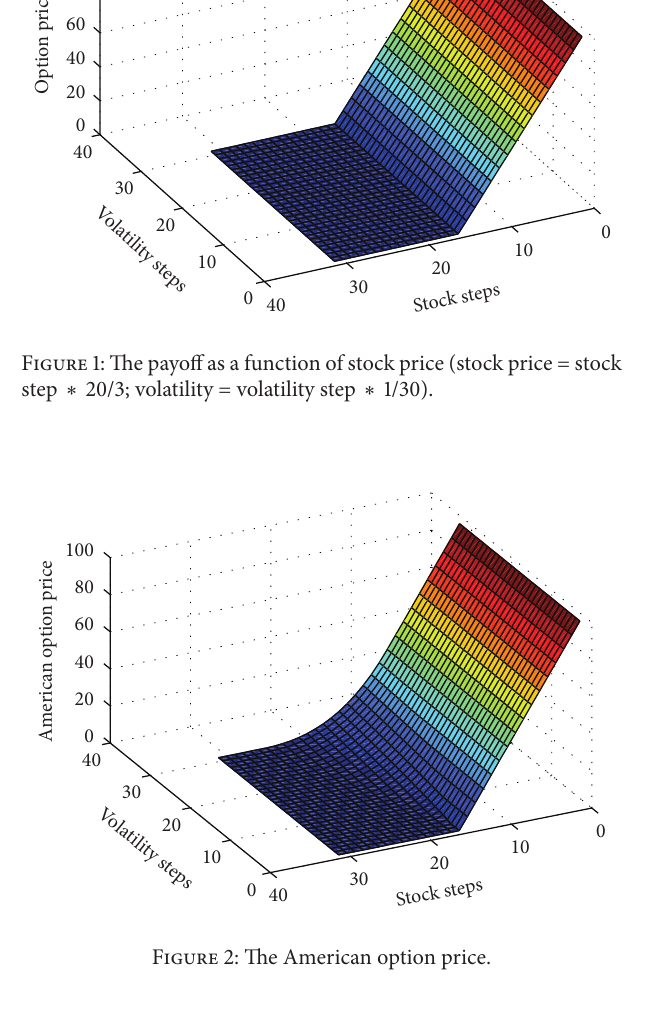
Figure 2. We also compute the value of American option price under various values of volatility. The results are plotted in Figure 3.